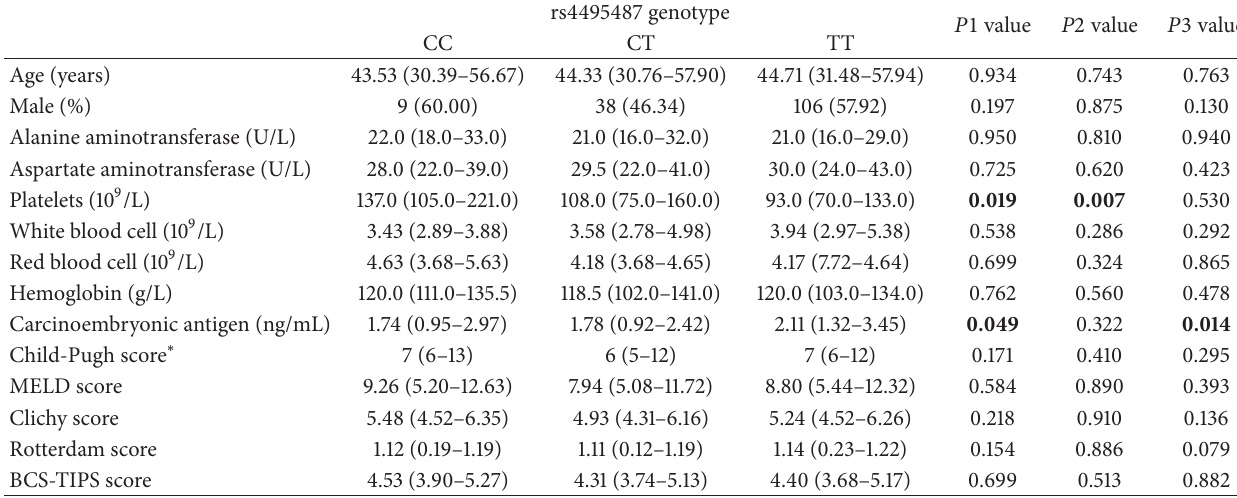
Table 3: Laboratory characteristics at presentation for Budd-Chiari syndrome patients with the JAK2 rs4495487 polymorphism.